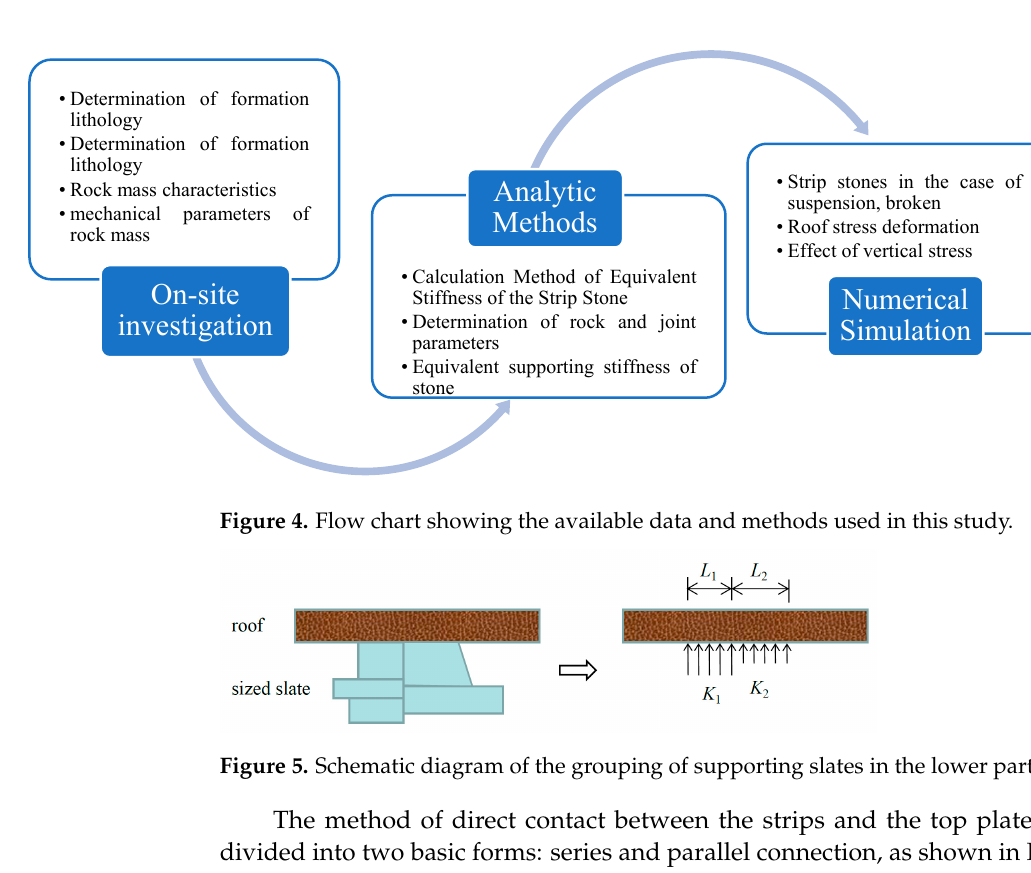
Figure 4. Flow chart showing the available data and methods used in this study (1) Calculation of equivalent stiffness of the sized slate